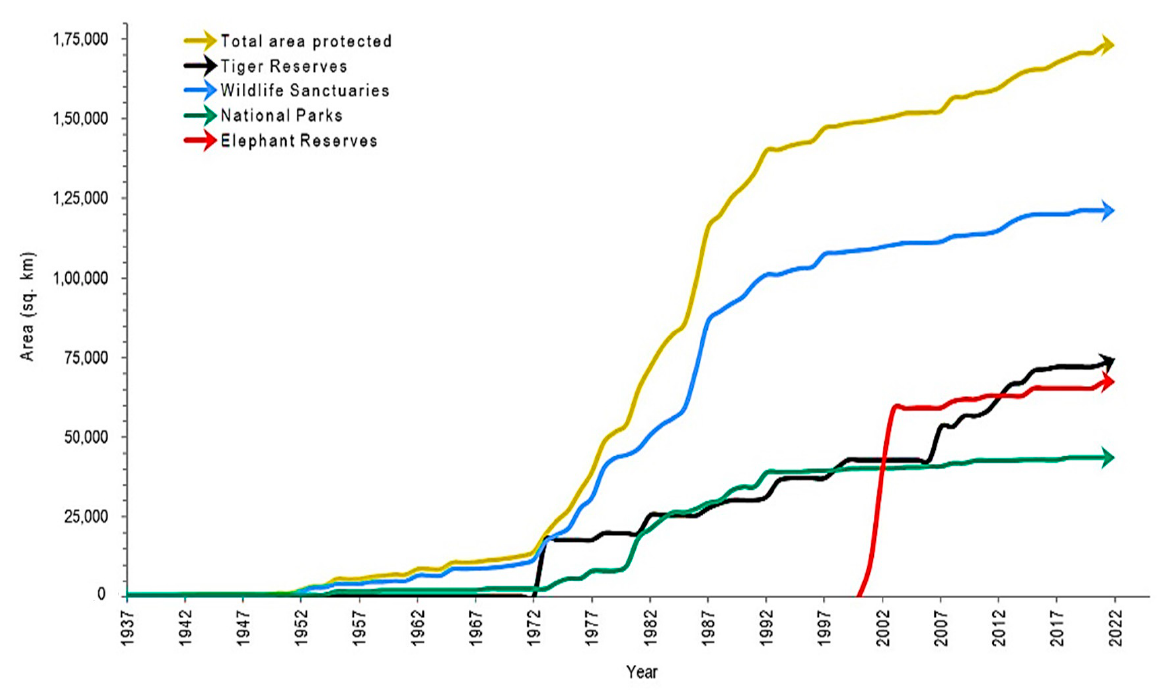
Figure 4. Depiction of changing legal protection of wildlife habitats in India before and after enact- ment of WPA (1972).